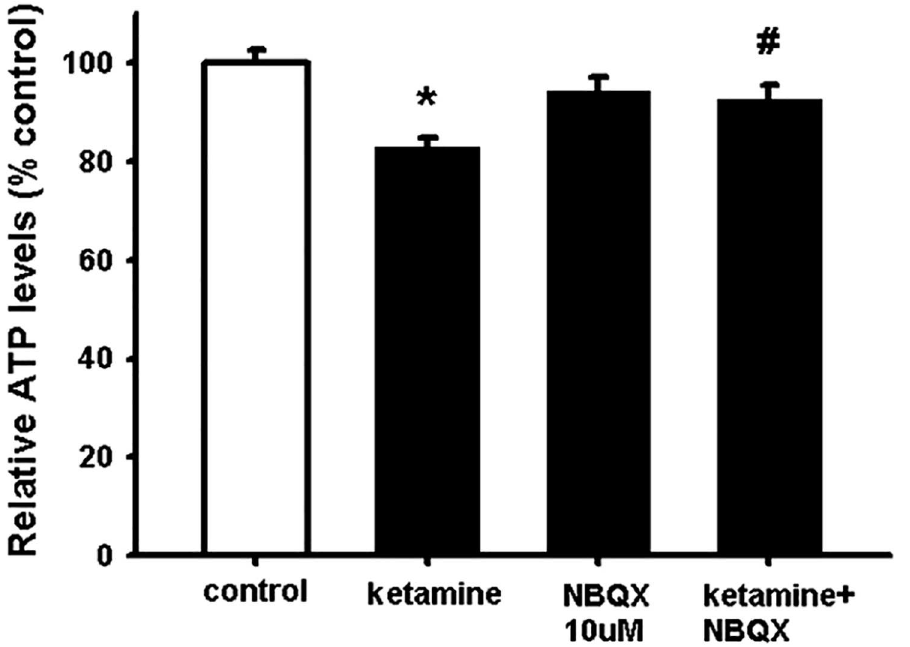
Fig 2. Ketamine impairs NSC viability via AMPA receptor activation. NSCs were plated as single cells and treated with 400 μ M ketamineor pre-treatedwith 10 μ M NBQX prior to 400 μ M ketamineexposure. After 24 hour incubation, intracellularATP levels were measured. Data are shown as mean ± SEM (n = 23–39). Kruskal-Wallis followedby Dunn’stest was used. Differences were considered significantat P < 0.05. * denotesP < 0.05comparedwith control, # denotes P < 0.05comparedto